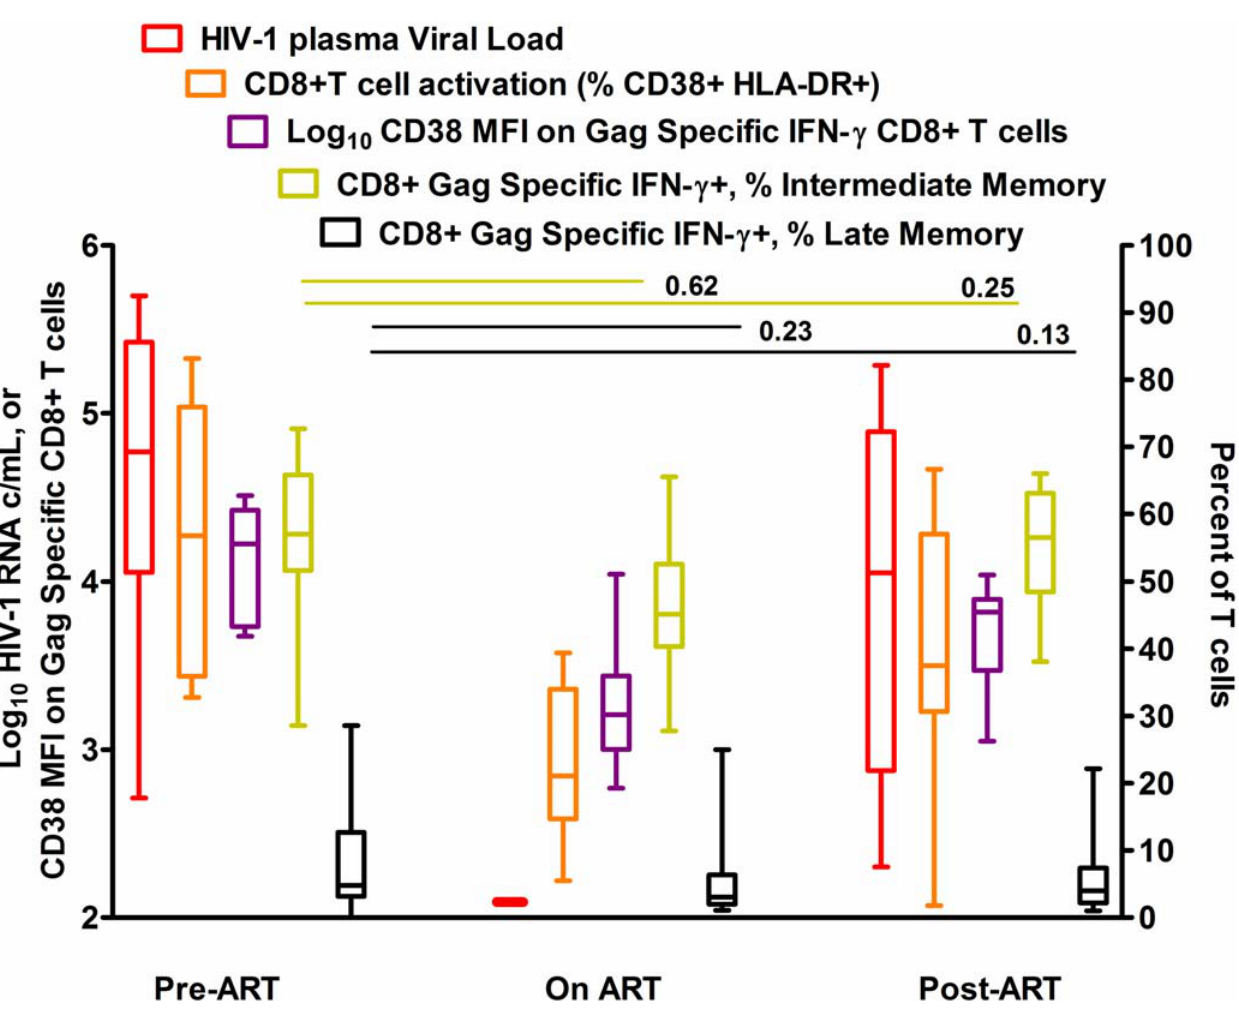
Figure 7. T cell activation declines during anti-retroviral therapy but maturation profile of Gag specific CD8 + T cells does not change HIV-1 RNA levels, total CD8 + T cell activation levels, HIV-1 specific CD8 + T cell activation levels and the proportion of HIV-1 Gag specific IM and LM CD8 + T cells at visit 1 (Pre-ART), visit 2 (On ART) and visit 3 (Post-ART). P-values for changes in viral load, Total and HIV-1 specific CD8 + T cell activation are shown in Table 1. HIV-1 RNA, total CD8 + T cell activation levels and HIV-1 gag specific CD8 + T cell activation levels all declined after initiation of ART. Black bars display p-values for a test of change in HIV-1 Gag specific CD8 + T cell IM and LM fractions from visit 1 to visit 2, and visit 3. Neither the Gag specific IFN- c + CD8 + IM or LM pool changed significantly from pre-therapy levels after therapy was initiated (On ART), or later halted (Post-ART).